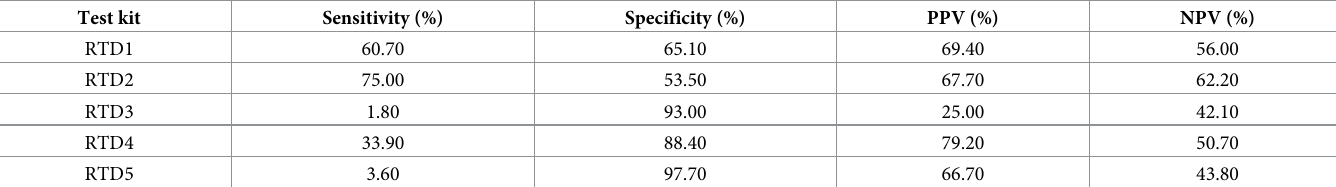
Table 2. Over all sensitivity, specificity, positive predictive value (PPV) and negative predictive value (NPV) of five rapid diagnostic tests. Test kit